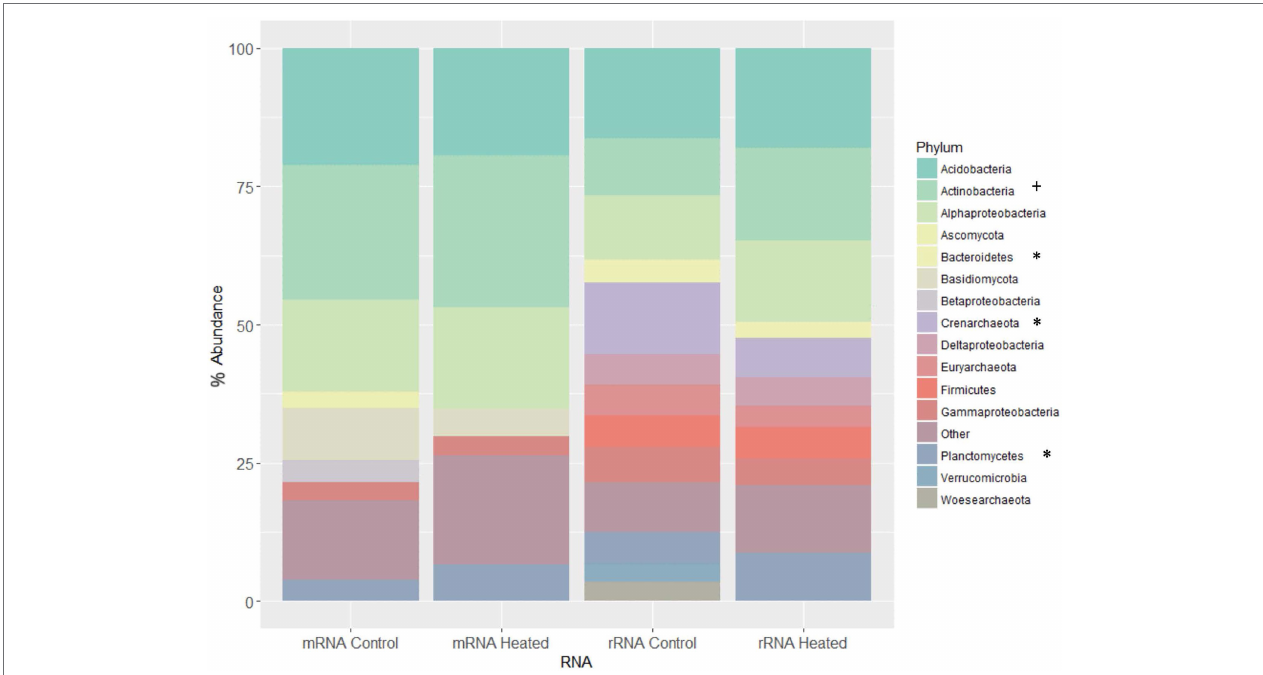
FIGURE 4 | Taxonomic classifications – community composition of heated and control samples using taxonomic assignments from both rRNA and mRNA reads in Organic horizon. “+” indicates enrichment and “ * ” depletion of phylum in heated compared to control plots. rRNA and mRNA reads were annotated using MATAM and MEGAN programs, respectively. Composition is computed using relative abundance and all assignments are given at the phylum level besides those for proteobacteria, which are at the class level. Note that assignments to eukaryotic phyla occur only for mRNA (as rRNA assignments are performed based on alignments for the 16S sequence, which occurs only in prokaryotes). Only phyla/classes occurring at >3% on average are shown and are otherwise grouped into “Other.” Only for rRNA assignments did phyla in Archaea exceed the 3% threshold for being graphed; no Archaea cleared 0.1% abundance in the mRNA